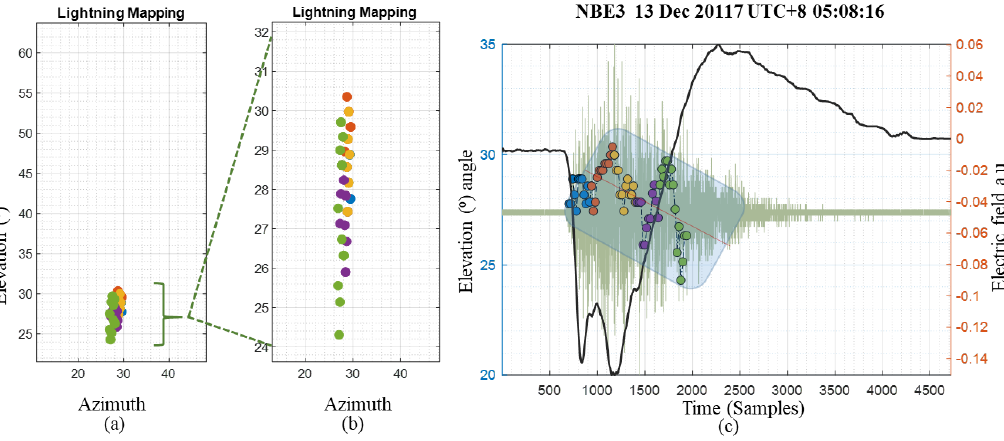
Figure 11. Interferometer data for NBE2: ( a ) lightning map plotted in elevation vs. azimuth; ( b ) expanded view of lightning map of ( a ); ( c ) the breakdown of each colored circle-marker denotes the elevation angles (altitude) vs. time.